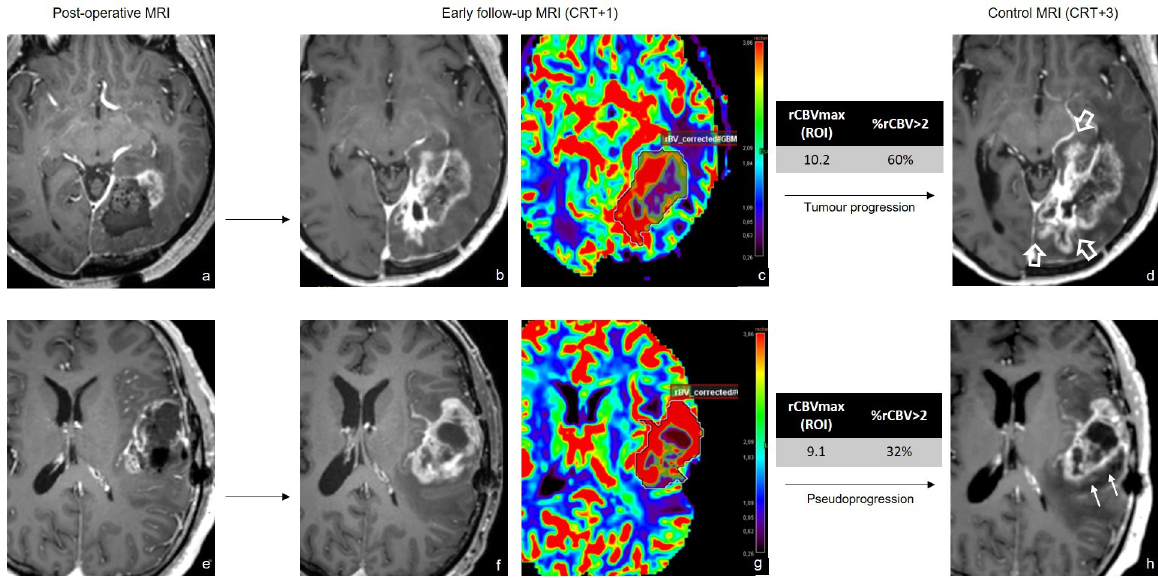
Fig 5. Longitudinal follow-up of two different glioblastomas with similar high rCBVmax (ROI) and different %rCBV > 2. Axial contrast- enhanced T1-weighted images (CE-T1WI) of post-operative MRI (a and e), showing progressive lesions on CE-T1WI of CRT+1 MRI (b and f) with their corrected rCBV maps (c and g) and subsequent evolution on CRT+3 MRI (d and h). Top line (a-d) shows tumour progression (arrows) at CRT+3, calculated rCBVmax was 10.1 and %rCBV > 2 was 60%. Bottom line (d-f) demonstrates regression of the lesion (thin arrows) indicative of pseudoprogression, despite high rCBVmax (9.1), %rCBV > 2 was 32% and could have predicted